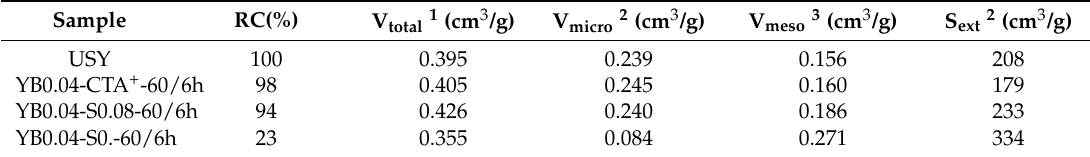
Table 5. Relative crystallinity and textural properties of the zeolites used to study the effect of the presence of the CTA +